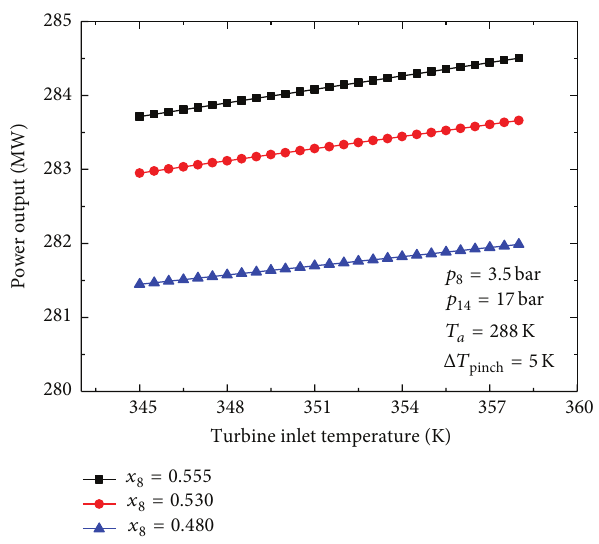
Figure10:Variationofpoweroutputofcombinedcyclewithturbine inlet temperature.